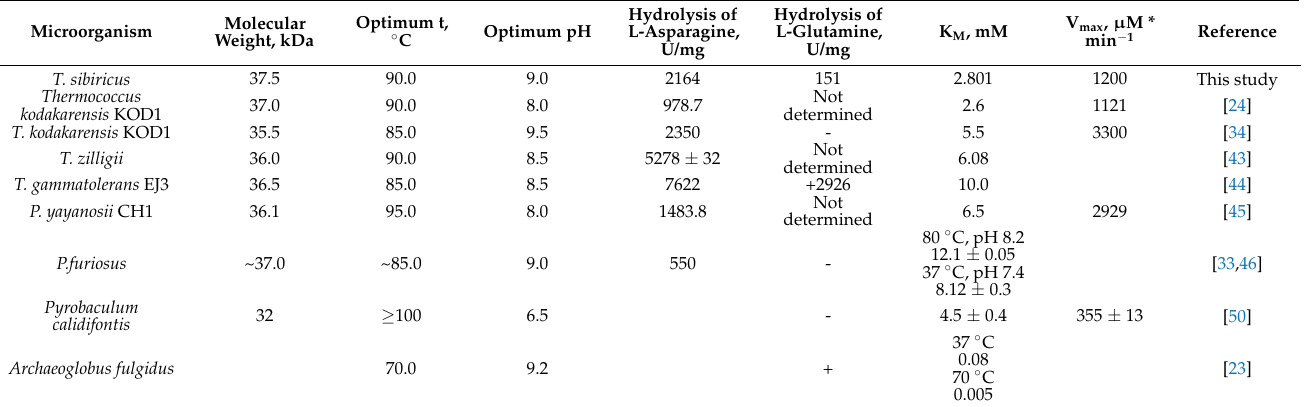
Table 3. The main biochemical properties and kinetic parameters of L-ASNases derived from thermophilic archaea. Microorganism Molecular Weight,